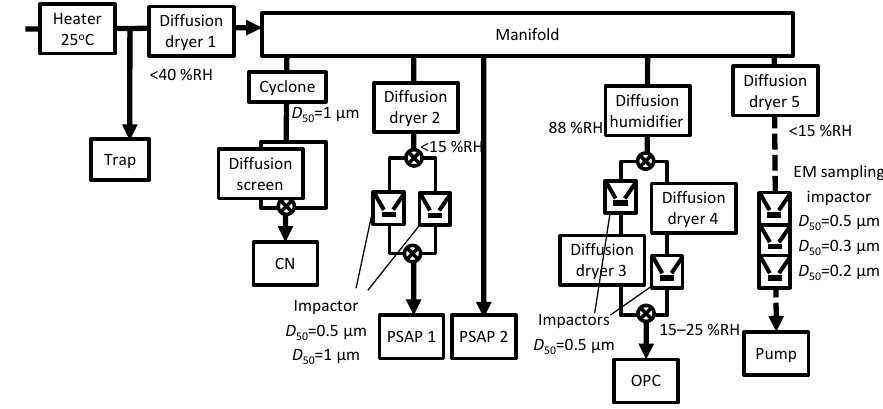
Figure 2. Flow diagram of a measurement system using the CN counter, PSAP, and OPC, and a sampling system for TEM samples. Solid arrow lines are sample air flow lines for consecutive measurements. Broken arrow lines show sample air flow for TEM